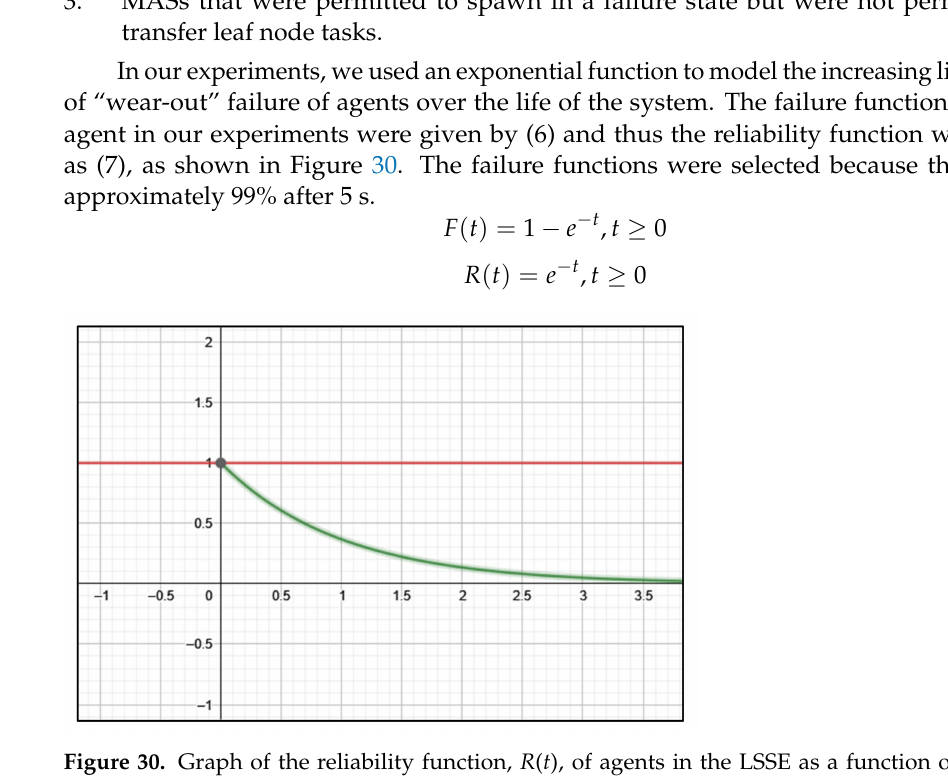
Figure 30. Graph of the reliability function, R ( t ), of agents in the LSSE as a function of time (in seconds, shown in